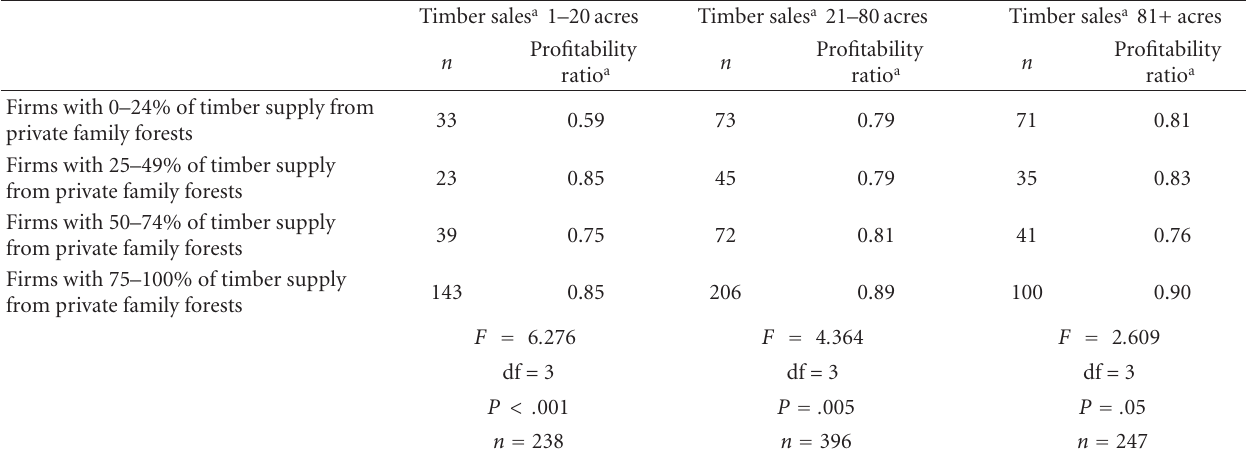
Table 3: Relationship between profitability of timber sales of varying sizes by source of timber supply (private family forests).